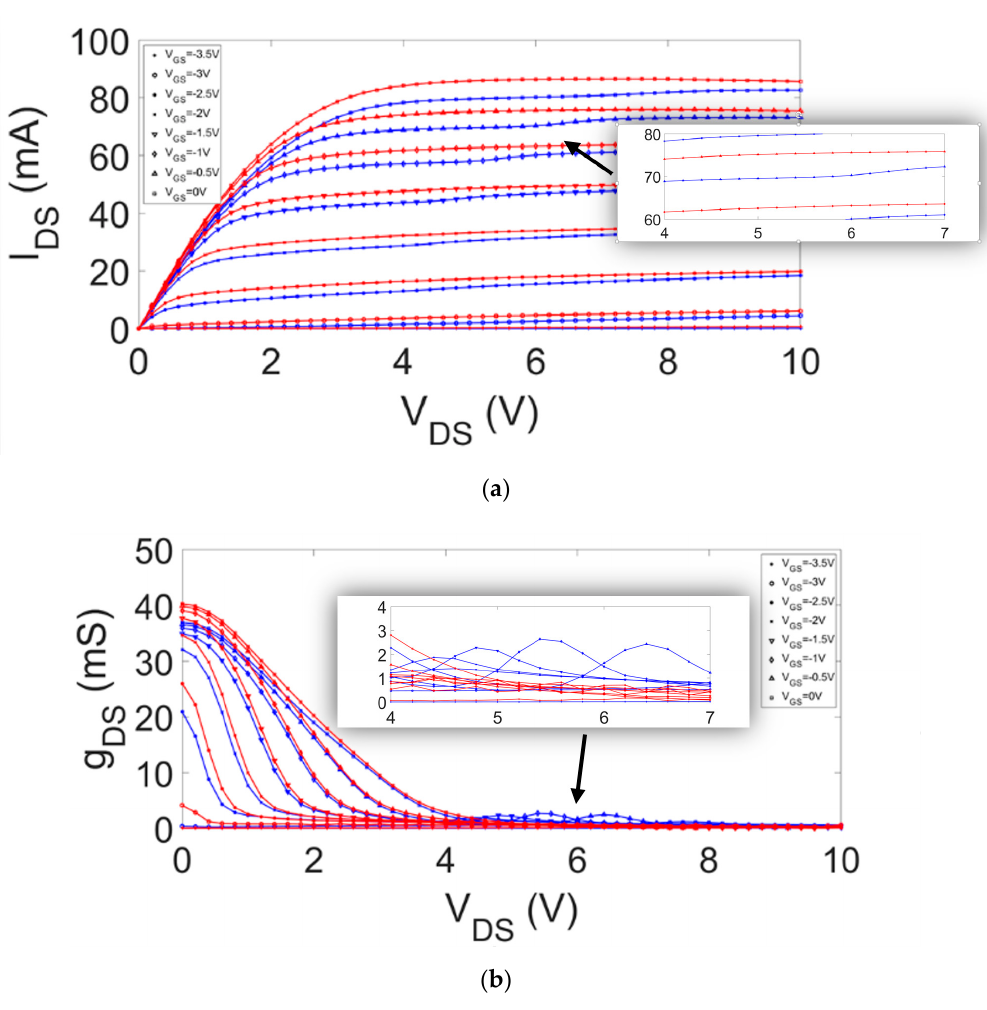
Figure 2. ( a ) I DS and ( b ) g DS versus V DS with V GS from − 3.5 V to 0 V (step 0.5 V) measured for the 100 µm high electron mobility transistor (HEMT) without (blue line) and with (red line) laser exposure.